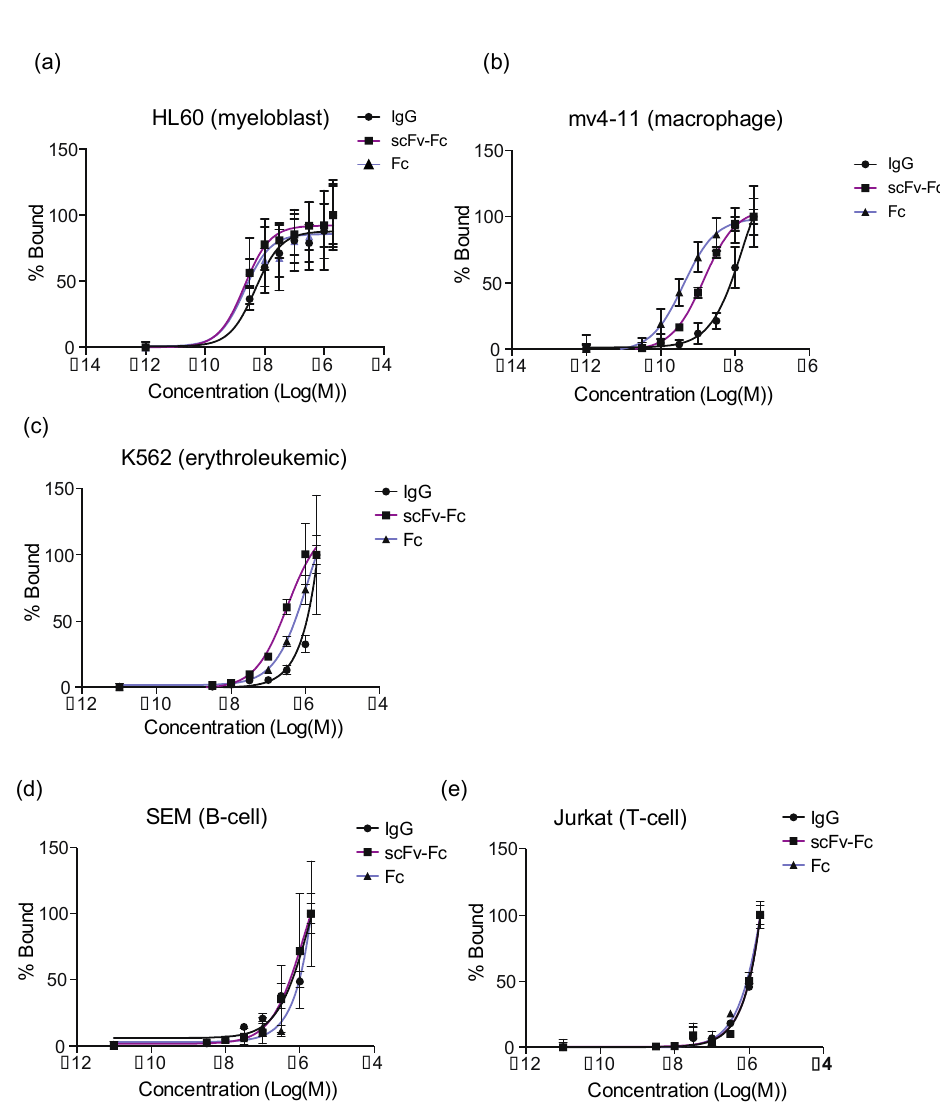
Figure 7. Binding of Fc-containing probes to cell lines using flow cytometry . The percentage of IgG, scFv, and Fc domain probes bound to indicated cell lines versus probe concentration. ( a ) HL-60 is a myeloblast cell line that differentiates into granulocytes. ( b ) Mv4-11 is a macrophage cell line. Jurkat is a T-cell line. ( c ) K562 are erythroleukemia cells that can spontaneously differentiate into erythrocytes, granulocyte and monocytes. ( d ) SEM is a B-cell line. ( e ) Jurkat is a T-cell line . The Mv4-11 and HL-60 cell lines, which represent macrophages (monocytes) and cells that spontaneously proliferate to neutrophils (granulocytes) or monocytes [20,21], respectively, bound to the Fc-containing probes with high affinity (Figure 7). The IgG, scFv-Fc, and Fc probes bound to the HL-60 cell line with binding constants of 5 ± 0.3, 2.1 ± 0.1, and 3.6 ± 2.3 nM, respectively, and to mv4-11 with binding constants of 1.7 ± 0.2, 1.5 ± 0.05, and 0.4 ± 0.02 nM, respectively.